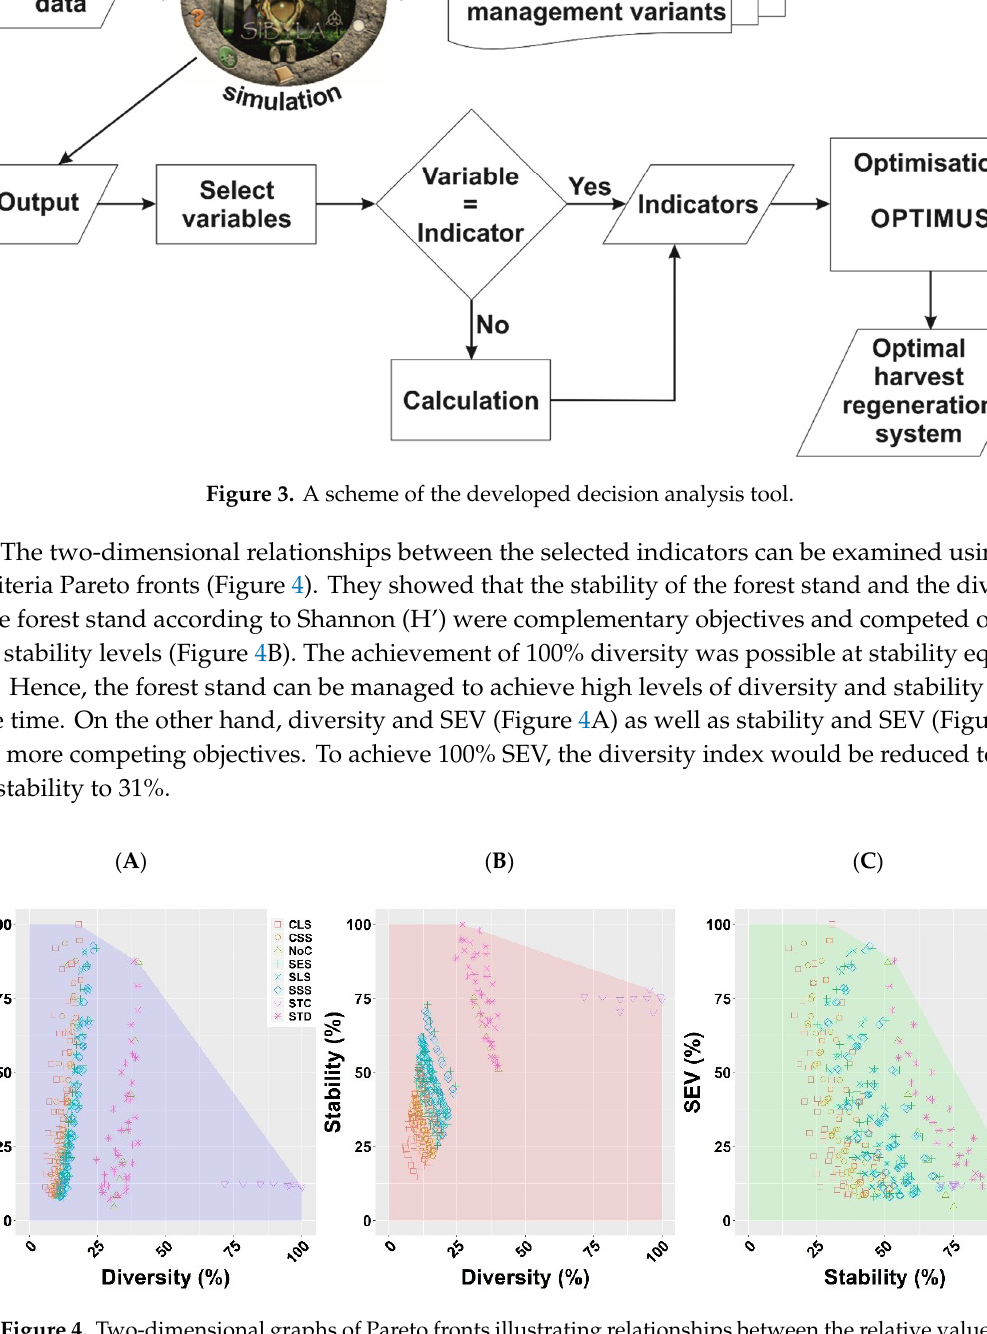
Figure 4. Two-dimensional graphs of Pareto fronts illustrating relationships between the relative values (%) of selected indicators: ( A ) forest stand diversity according to Shannon (H´) and soil expectation value (SEV), ( B ) forest stand diversity and forest stand stability (1-H / D), and ( C ) soil expectation value (SEV) and forest stand stability of (1-H / D). The points in the graph represent all 450 simulated harvest-regeneration variants. Legend: CLS = large-scale clearcutting system, CSS = small-scale clearcutting, NoC = no cutting, SES = shelterwood expanding scale, SLS = shelterwood large scale, SSS = shelterwood small scale, STC = selection single tree cutting system, STD = shelterwood based on target diameter.